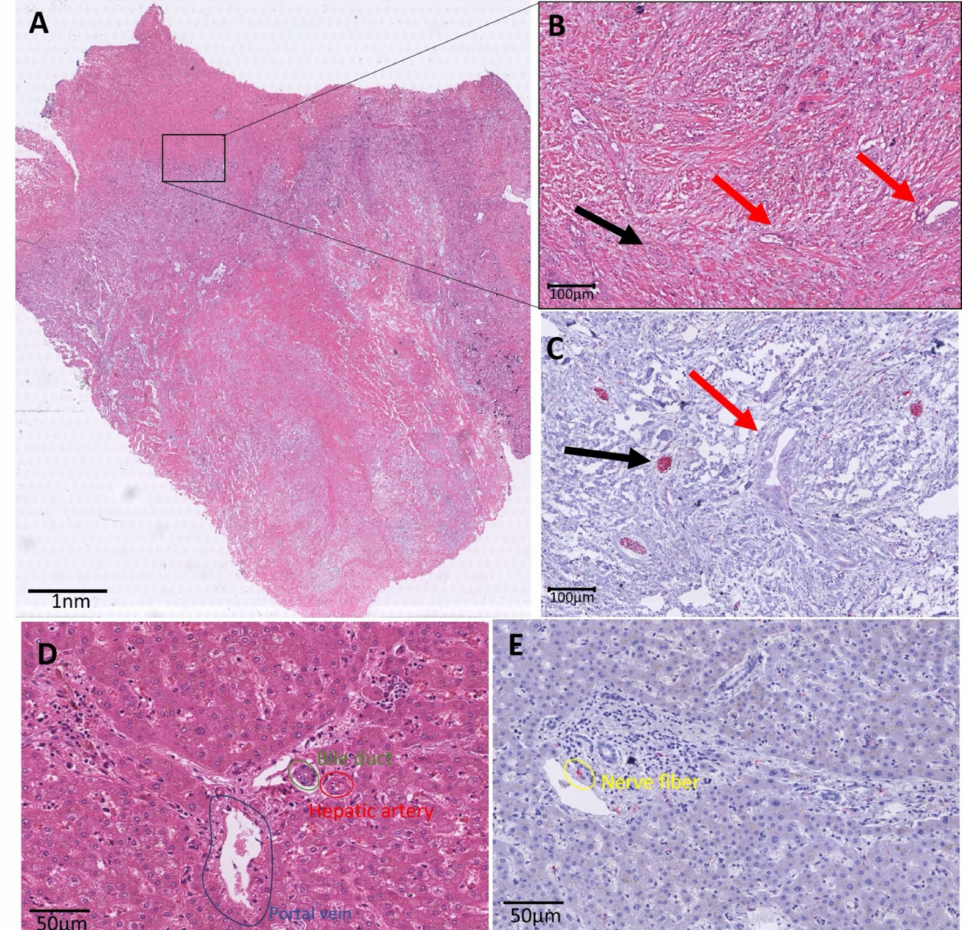
Figure 4. Histology overview of iCCA. ( A ): Whole slide H&E image of an iCCA. At the edge of the slide, normal liver parenchyma is displayed. More centrally, a lesion is shown with a rim of vital tumor cells, and centrally, a pale area corresponding with necrosis. ( B ): Zoomed in image of the black marked box in A. This H&E image shows small tumor glands in abundant stroma marked with red arrows. The black arrow points to a nerve fiber, which is not easily visible on this HE staining. ( C ): Black box area in the immunohistochemical PGP9.5 staining. This staining makes it easier to recognize the small nerve fibers (red in the PGP9.5 immunohistochemistry and marked with a black arrow). The red arrow is pointed at the tumor. ( D ): Zoomed in image of a portal tract. The portal tract illustrates the bile duct (marked in green), the hepatic artery (marked in red) and the portal vein (marked in blue). ( E ): Zoomed in image of a portal tract with PGP9.5 staining. In this zoomed in image, the small nerve fiber is nicely illustrated in red (positive immunohistochemical staining) and marked in